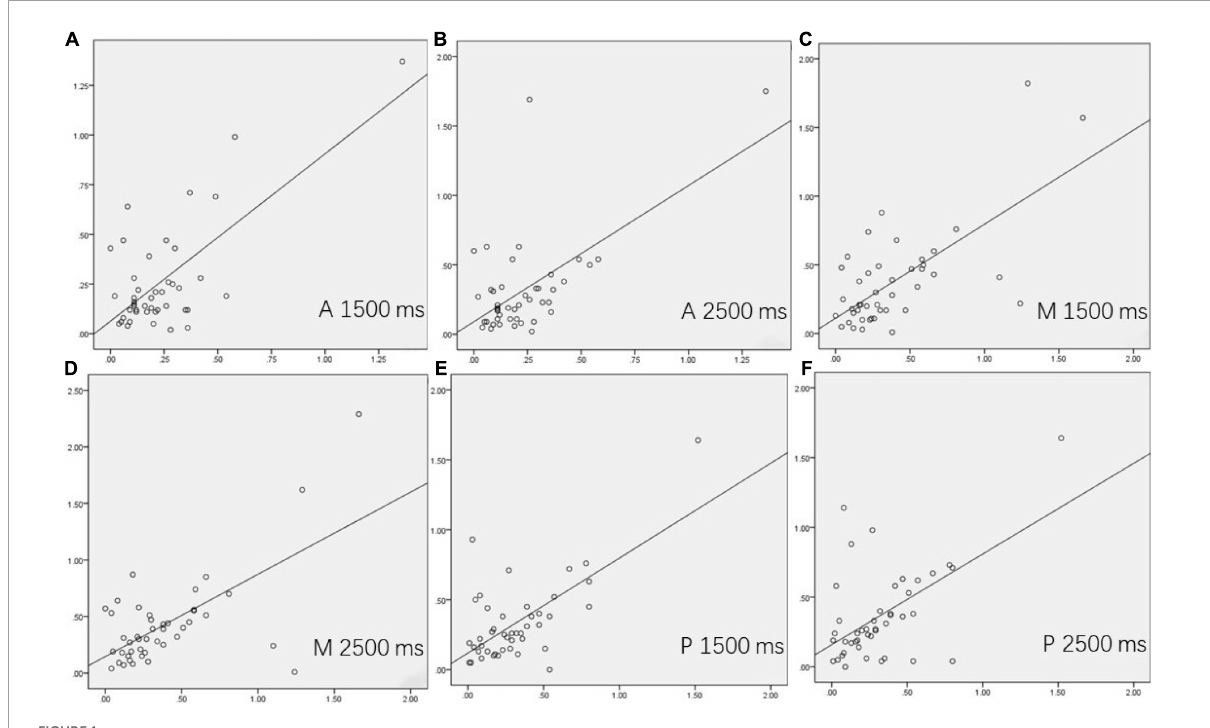
FIGURE1 The correlations between dynamic susceptibility contrast-cerebral blood flow (DSC-CBF) minus and arterial spin labeling (ASL)-CBF minus (1,500 ms) and between DSC-CBF minus and ASL-CBF minus (2,500 ms) in 44 surgical patients. (A–F) showed the correlation of the supply territories of ACA, MCA, and PCA between DSC-CBF minus and ASL-CBF minus (1,500 ms) and between DSC-CBF minus and ASL-CBF minus (2,500 ms) on the surgical side.